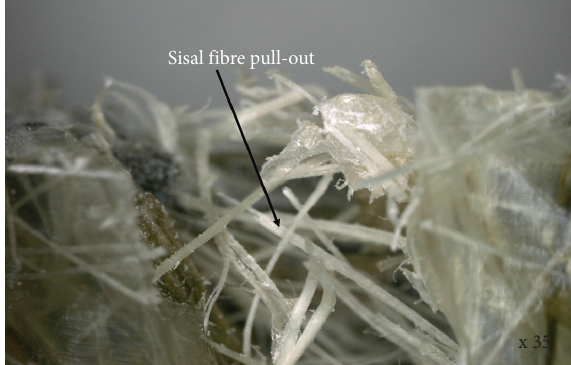
Figure 8: Micrograph showing the reinforcing effect of sisal and cattail fibres.